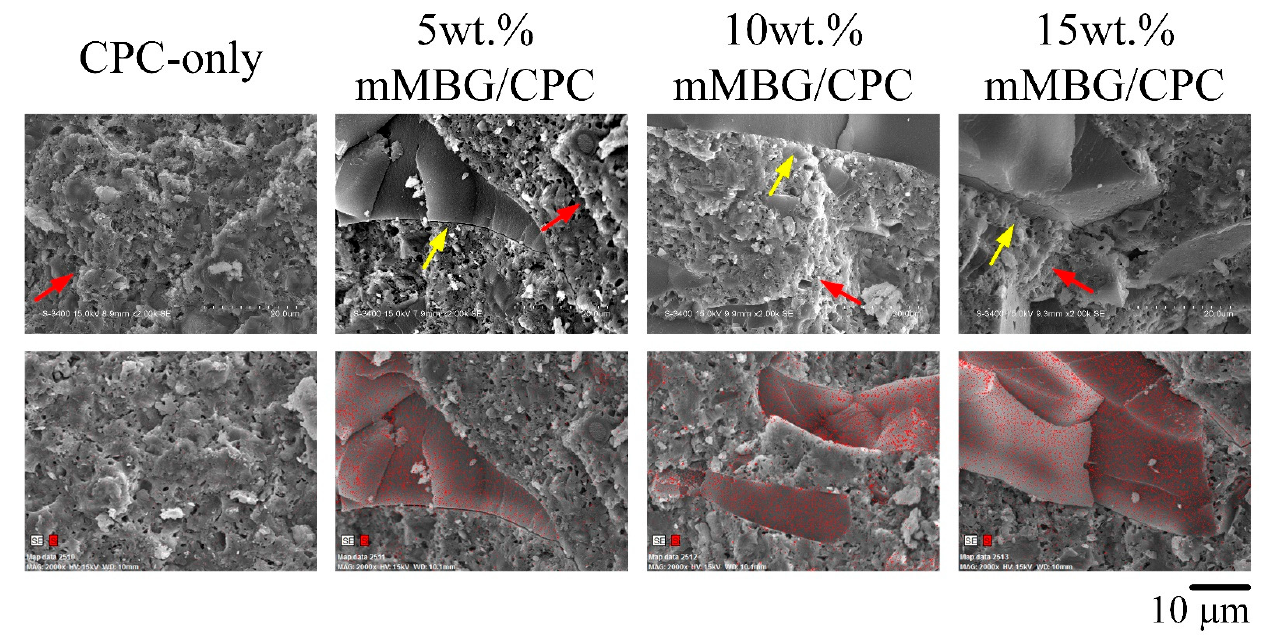
Figure 3. Fractured surfaces of the specimen after compression; SEM images and Si elemental mapping (red arrow: HA, yellow arrow: mMBG) of control CPC-only and mMBG/CPC composite bone cements with different mMBG ratios immersed in Tris-buffer for 1 day.